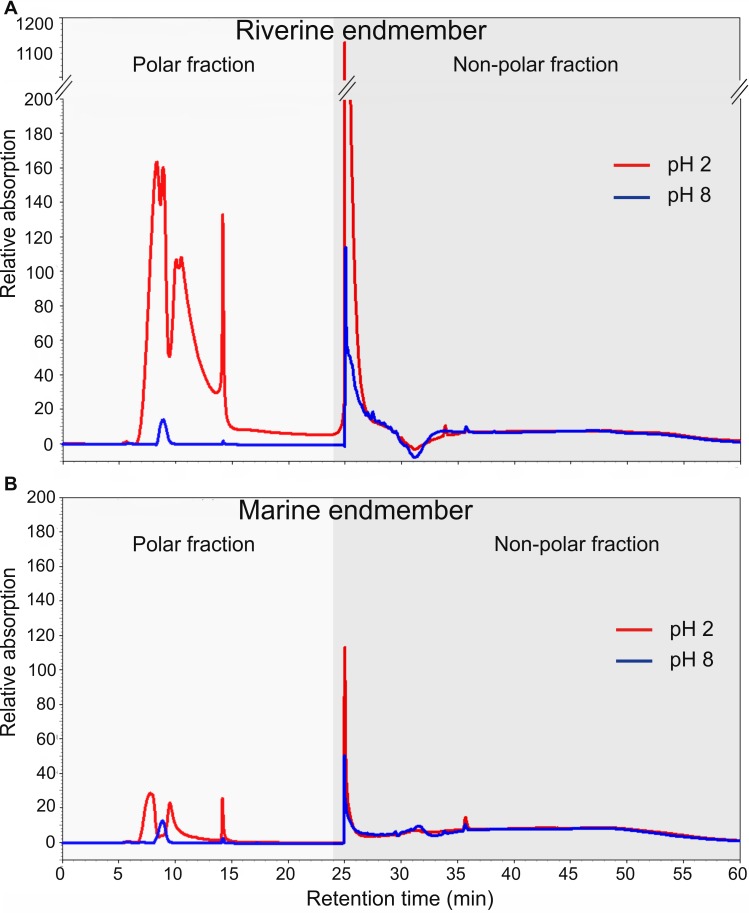
UV absorption chromatograms of riverine and marine methanol extracts at 210 nm.(A) Chromatograms of riverine pH 2 (red) and pH 8 (blue) extracted samples. (B) Chromatograms of marine pH 2 (red) and pH 8 (blue) extracted samples.